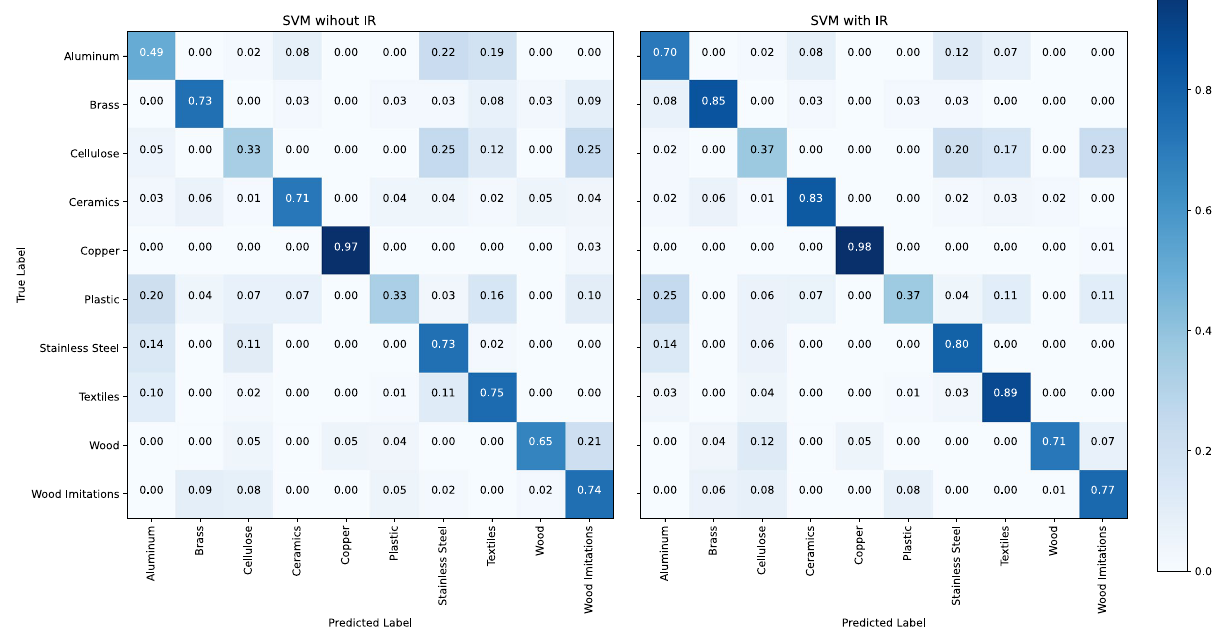
Figure 6. Confusion matrices from the cross validation test. The mean accuracies are shown when the feature vector is classified with dropped IR data (left) and with included IR data (right).